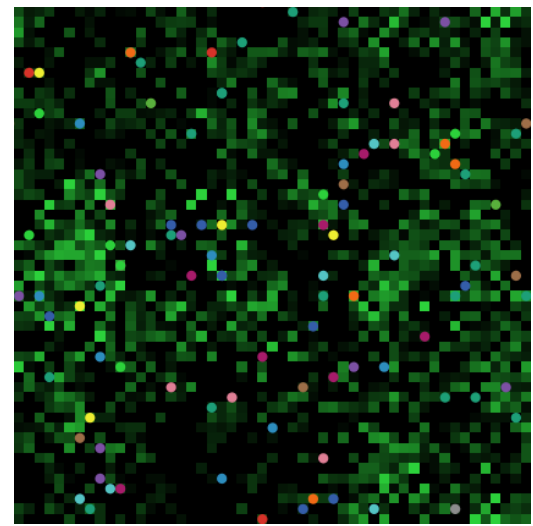
Fig. 2. Example of the state of the forest in the open- access model, representing the forest after 1000 rounds. Green indicates the amount of tree biomass: darker patches indicate lower tree biomass; lighter patches indicate higher tree biomass. Black indicates complete removal of trees. Circles indicate